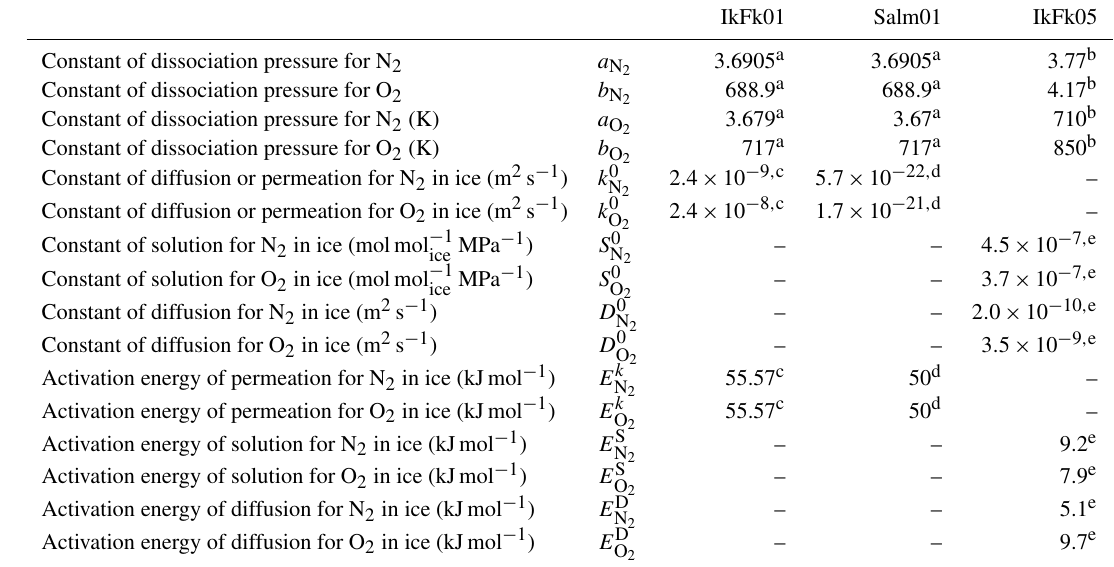
Table A3. Examples of dissociation pressure, diffusivity, solubility, and permeability (at 240K). Dissociation pressure of N 2 (MPa) P d Dissociation pressure of O 2 (MPa) P d Dissociation pressure of Ar (MPa) P d